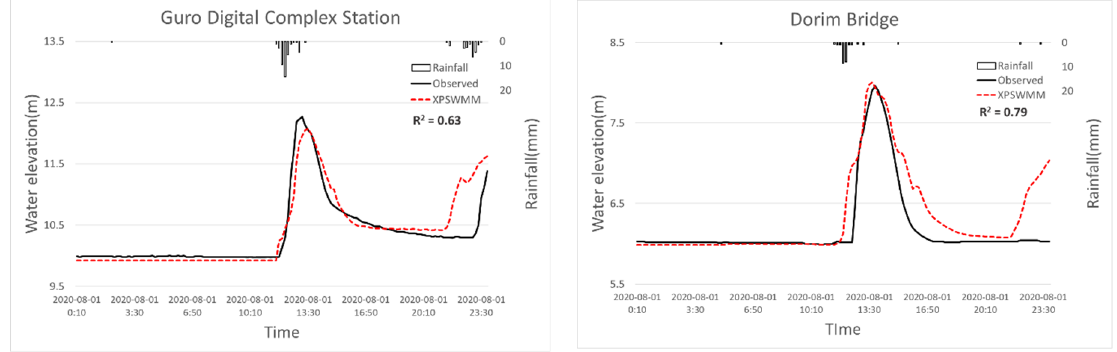
Figure 7. Calibration results of the water level in Dorim stream (01 August 2021).